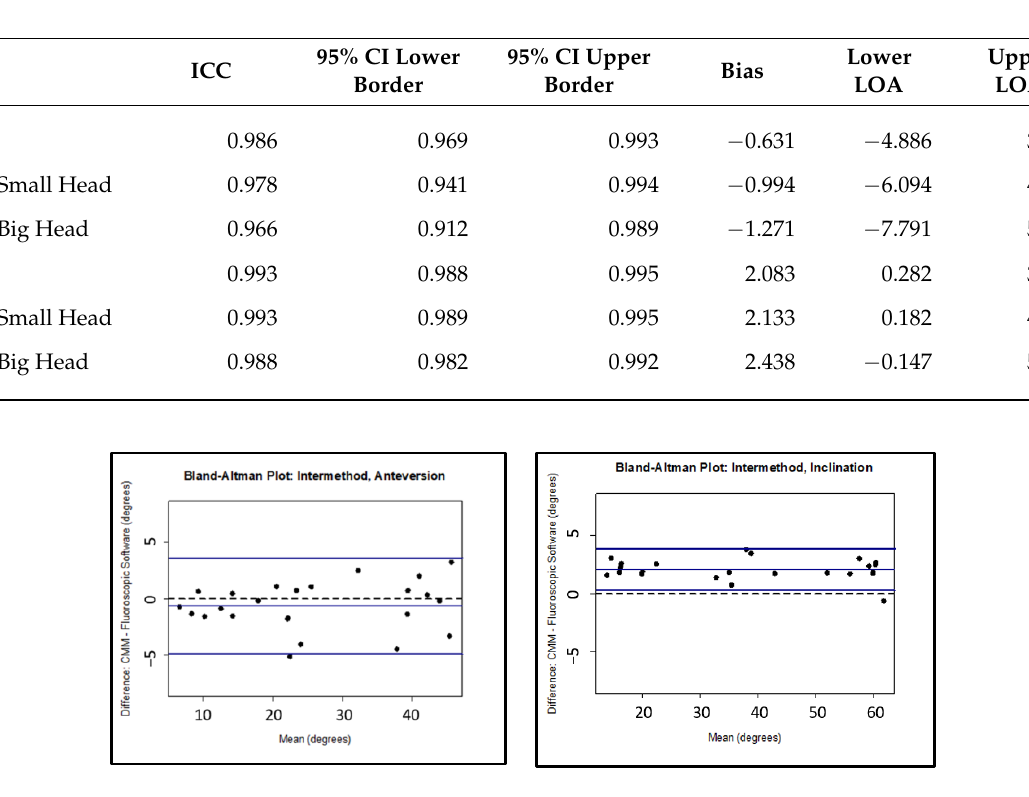
Figure 7. Bland – Altman limits of agreement for the intermethod analysis comparing the software analysis to the CMM analysis for the cup only images.